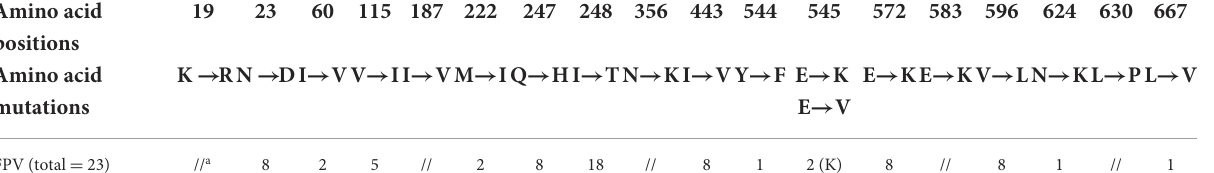
TABLE 3 Statistics of mutation sites and rates in the NS1 gene from FPV and different CPV-2 genetic variants. Amino